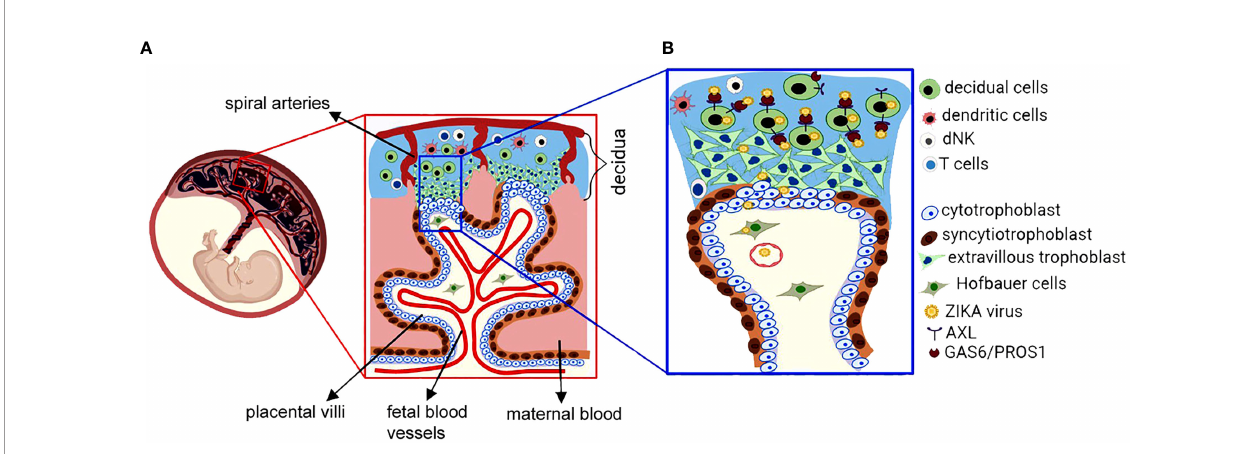
FIGURE 1 | Schematic presentation of the maternal-fetal interface and ZIKA virus infection. (A) The fetus-derived placental villi, which are bathed in maternal blood within intervillous space are composed of fl oating villi and anchoring villi that invade the maternal decidua. The maternal decidua consists of decidual cells that differentiate from uterine endometrial stromal cells, maternal blood vessels and maternal immune cells consisting of decidual natural killer (NK), dendritic cells (DC) and T cells. The placental villi are composed of fetal blood vessels, villous fi broblasts and Hofbauer cells in the villous core as well as proliferative cytotrophoblasts and multinucleated syncytiotrophoblasts, which cover the surface of the placental villous and direct contact to maternal blood. Extravillous trophoblasts are differentiated from cytotrophoblasts and invade the maternal decidua and maternal spiral arteries. Substantial crosstalk exists between maternal decidual cells and fetal trophoblasts that are essential for a successful pregnancy. (B) Representative presentation of decidual cell-mediated vertical transmission of the ZIKA virus. The enlarged inset represents the potential route of ZIKA virus (ZIKV) transmission from decidual cells to fetal cells. At the maternal-fetal interface, decidual cells exhibit higher viral entry/attachment factors AXL, GAS6 and PROS1 and they are more permissive to direct ZIKV infection in a gestational age-dependent manner compared to extravillous trophoblast or cytotrophoblast cells. Thus, ZIKV infects and spreads via decidual cells to fetal trophoblasts or Hofbauer cells or fetal endothelial cells. Therefore, decidual cells act as reservoirs for trimester-dependent placental transmission of ZIKV, thereby accounting for the higher ZIKV-infection susceptibility and more severe fetal sequelae observed in early versus late